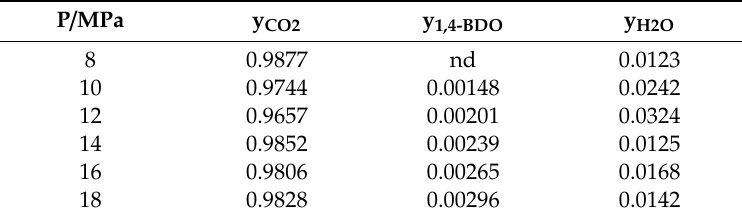
Table 3. Vapour-liquid equilibrium data for the quaternary (CO 2 + 1,2-PDO + [hmim][B(CN) 4 ] + H 2 O) system at 313.2 K 1 (data presented refer to the gas phase).